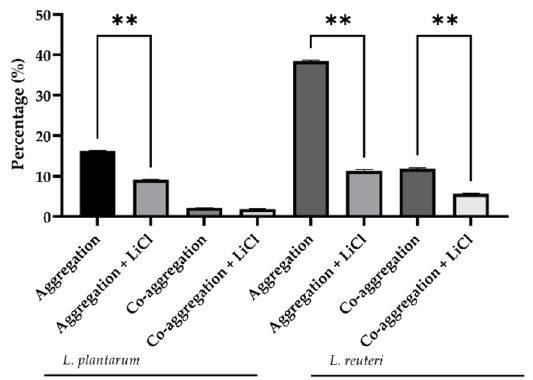
Figure 2. Percentage of L. reuteri and L. plantarum aggregation and co-aggregation with E. coli F18 measured at 6 h. Data are presented as LS mean ± SEM. ** indicates a statistically significant difference ( p ≤ 0.001).